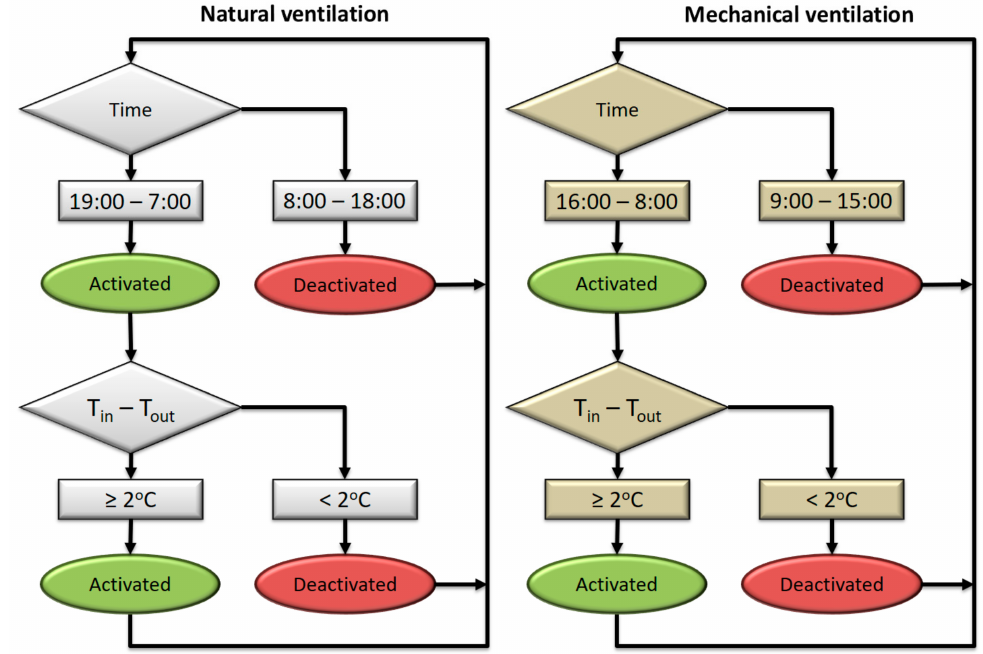
Figure 7. Schematic representation of ventilation of the modeled